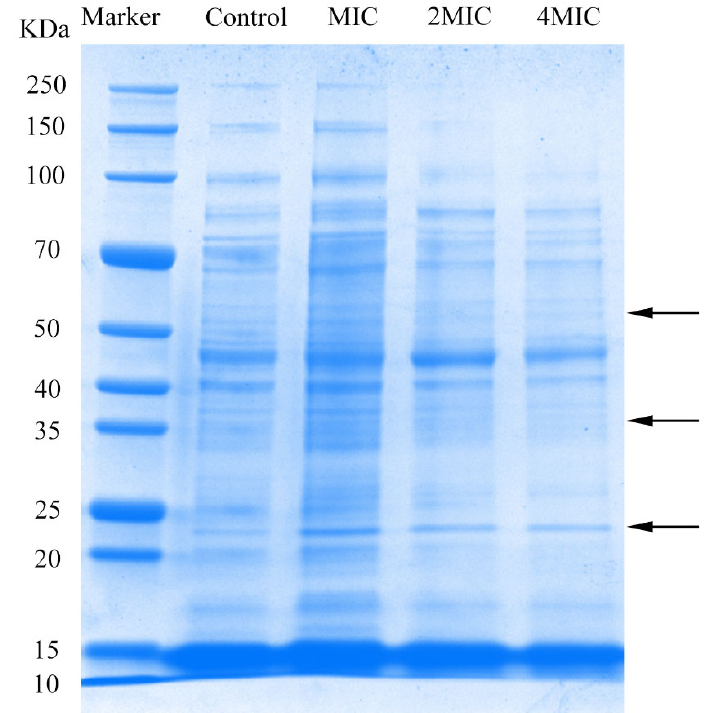
Figure 8. SDS-PAGE analysis of intracellular soluble proteins of L. monocytogenes not treated with juglone and treated with juglone at MIC, 2MIC, and 4MIC; the arrows are mainly to illustrate the changes of protein bands. The molecular weight range represented by the arrows corresponds to the Marker on the left.